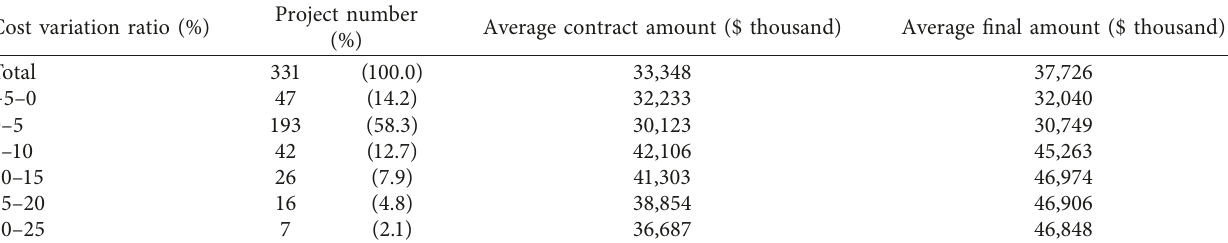
Table 2: Cost variation ratios of sample projects.